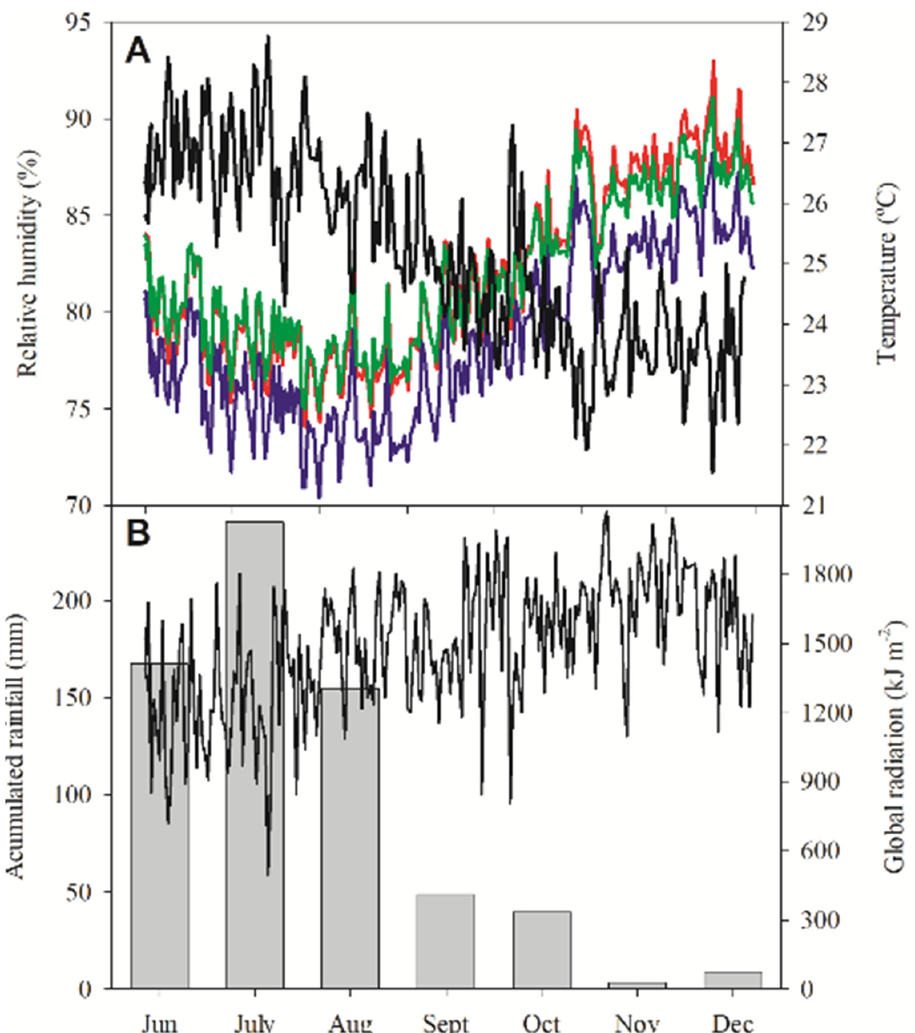
Figure 1. Climatological data. ( A ) Minimum (blue), maximum (red), and mean (green) temperature (right axes), and relative humidity (left axes). ( B ) Accumulated rainfall (left axes) and global radiation (right axes). All data were automatically registered by a climatologic tower daily between 1 June 2020 and 31 December 2020. Source INMET